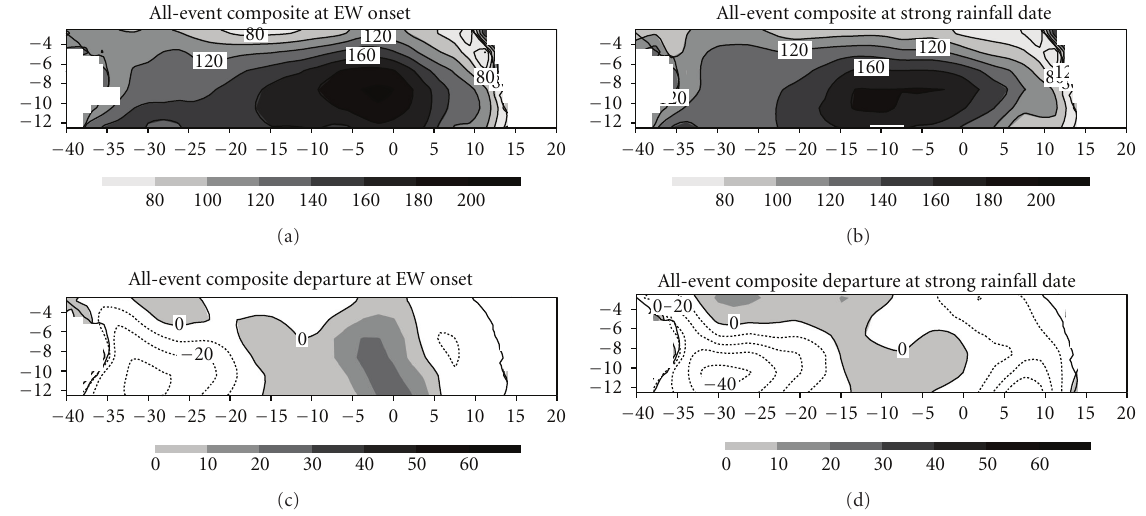
Figure 12: Latitude-longitude composite values ((a), (b)) and composite anomalies ((c), (d)) of LH flux (W · m − 2 ) during the onset of EWs ((a), (c)) and during the day (or first day) of strong rainfall anomaly ((b), (d)) over ENEB. Positive values (energy lost by ocean evaporation) are shaded.